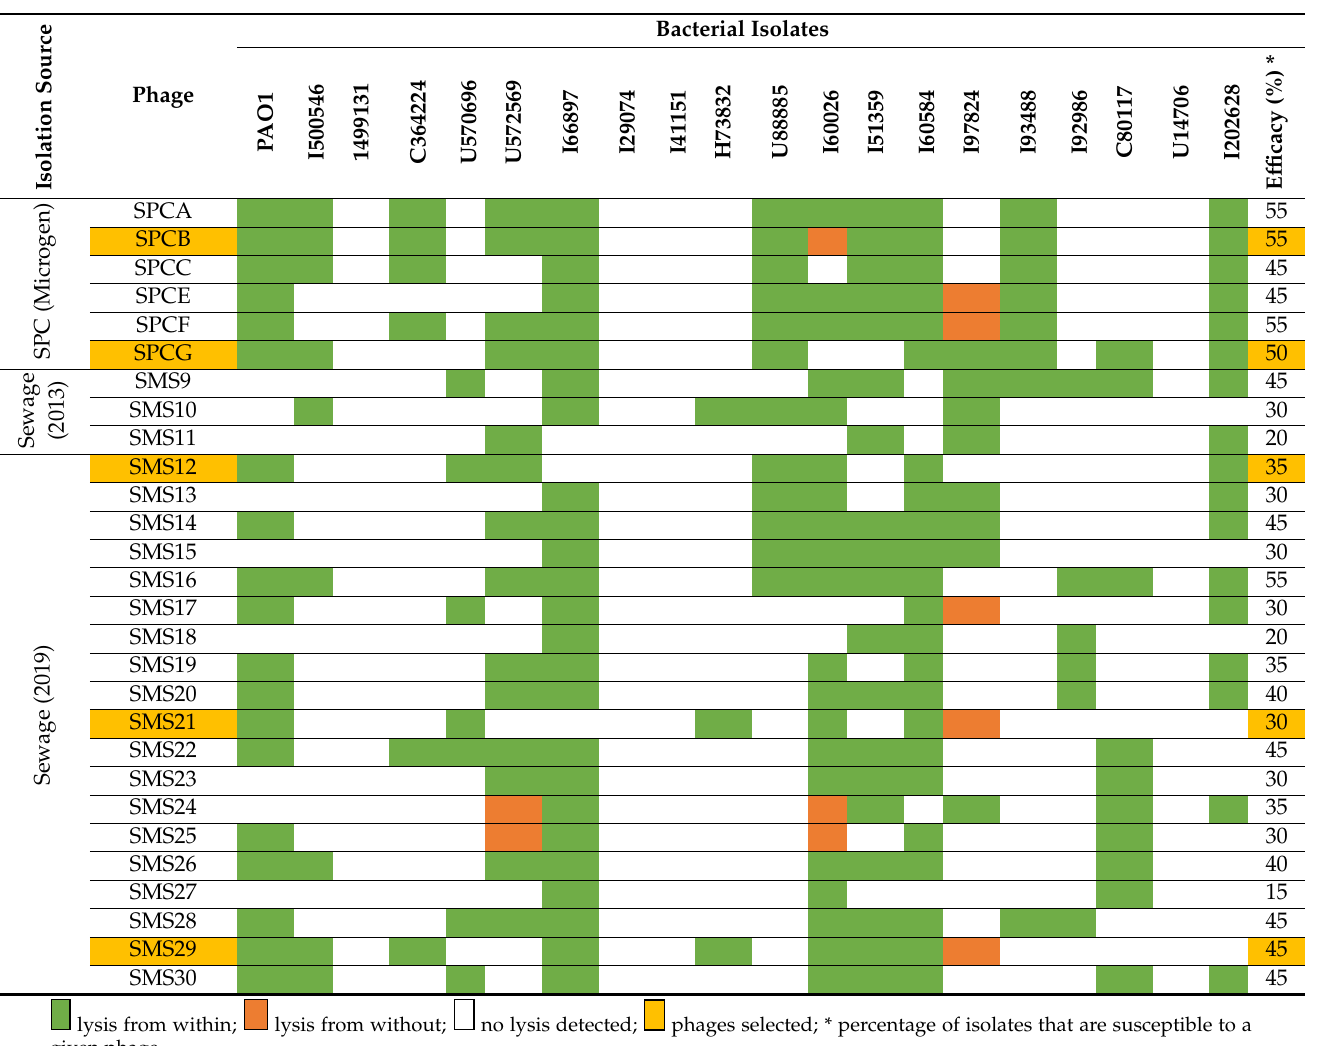
Table 2. Lytic spectra against P. aeruginosa PAO1 and different clinical isolates .